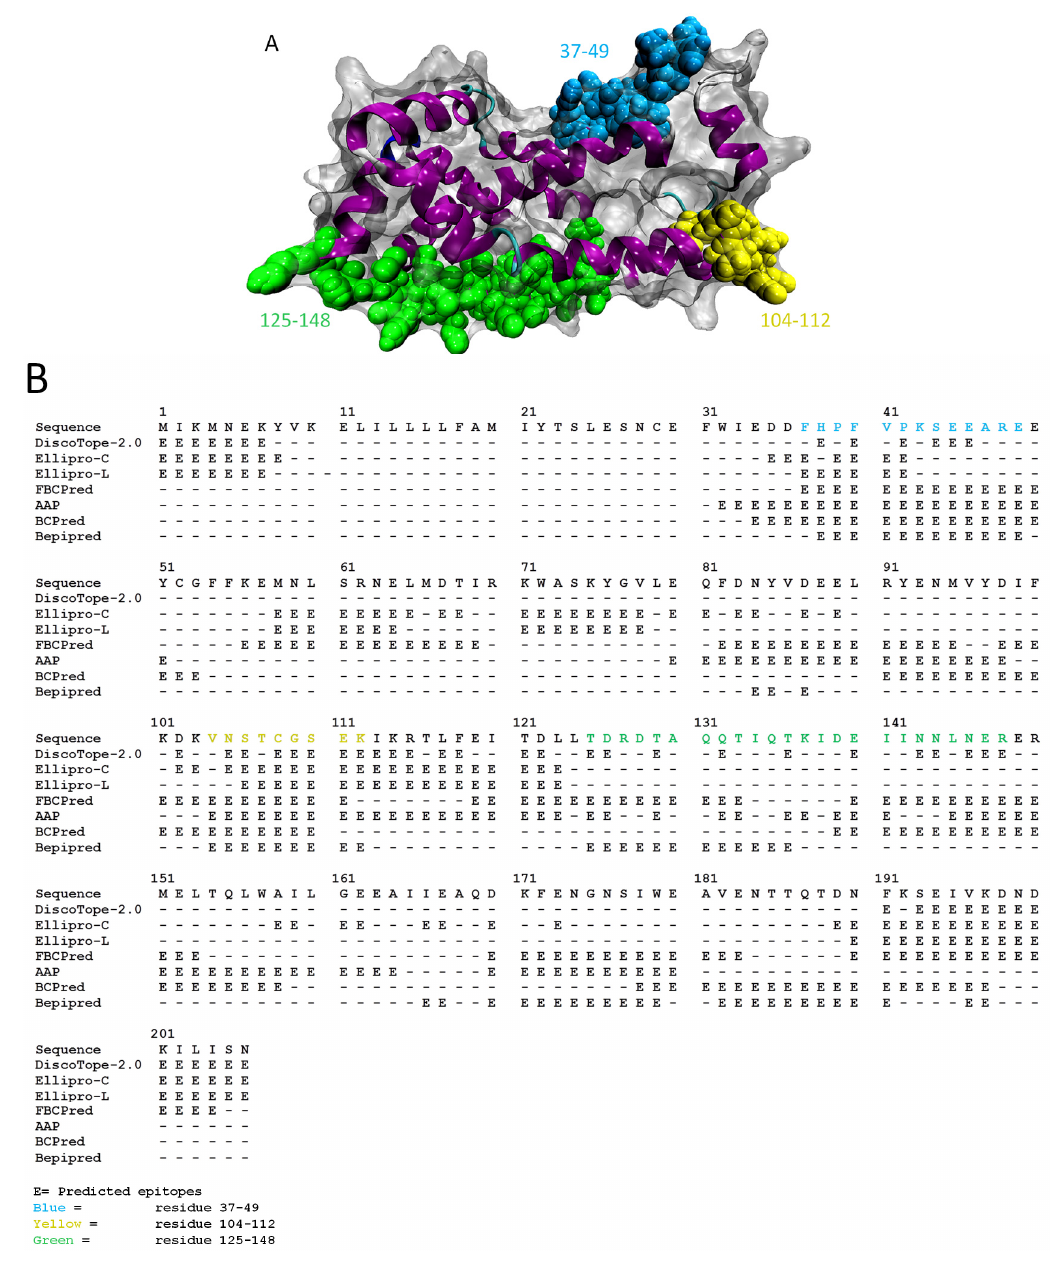
Figure 4. ( A ) Surface representation of built structure of average MD Bm R1 structure with predicted potential epitopes (residues 37–49, 104–112 and 125–148); ( B ) Predicted epitopes from Ellipro [32], DiscoTope-2.0 [36], FBCPred [33], AAP [34], BCPred [33] and Bepipred [35]. Ellipro-C represents predicted conformational epitopes and Ellipro-L represents predicted liner